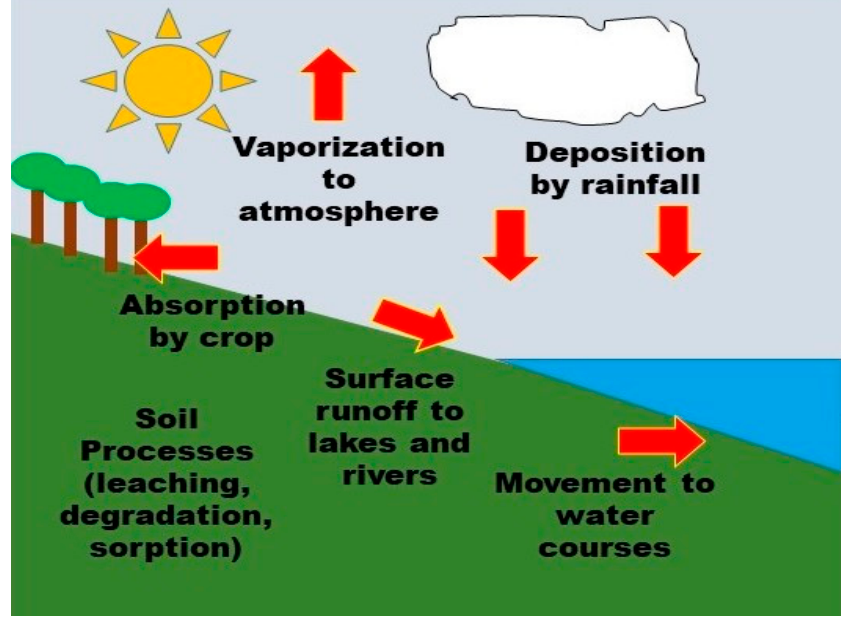
Figure 2. Pesticide behavior in the natural environment (by authors).